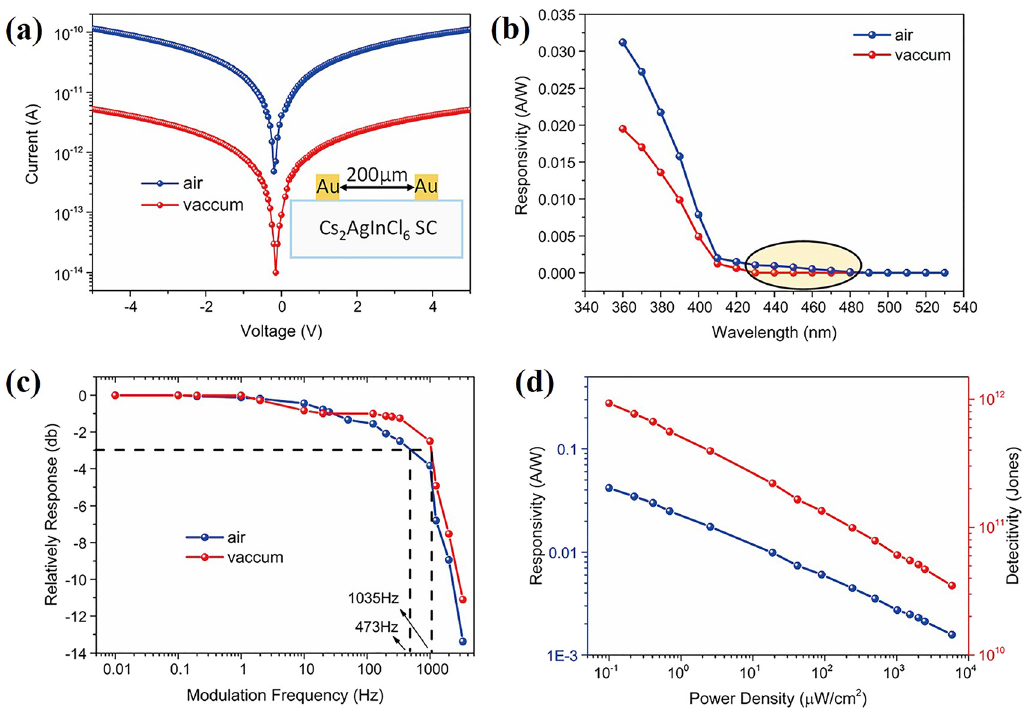
Figure 8: (a) The current − voltage characteristic of the detector in dark condition. Inset: the device configuration for photoconductive planar detector. (b) Normalized response of the detector vs. the input signal frequency (light intensity of 1.27 mW cm − 2 ) at a bias voltage of 5 V. The − 3 dB point is marked with the dashed line. (c) Wavelength-dependent responsivity under 5 V bias. The light source is the bromine tungsten lamp modulated by optical grating to generate monochromatic light with a minimum step of 10 nm. (d) Light intensity-dependent responsivity and normalized detectivity under the bias of 5 V in vacuum. Reproduced with permission. Copyright 2017, American Chemical Society